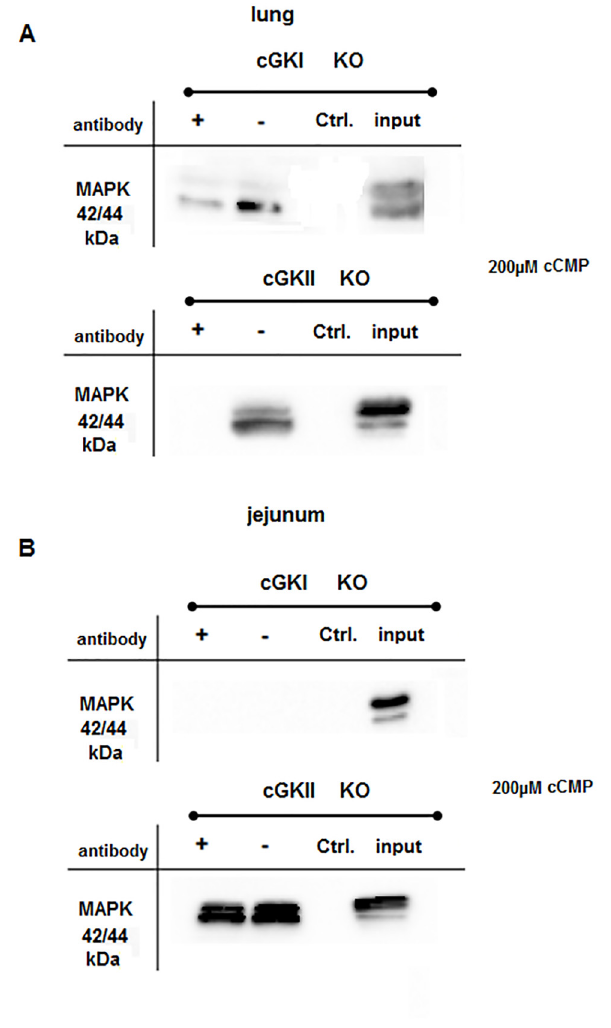
Fig 5. Identification of cCMP-binding proteins (A) Lung tissue lysate (cGKI KO or cGKII KO) was incubated with 4-AH-cCMP agarose beads or EtOH-NH-agarose beads (ctrl). For the competition experiments, cCMP (200 μ M) was added (+) or omitted (-) as described in the Material and Methods. Untreated tissue lysate (1 μ g/ μ L, indicated with input) was used as an additional control. cCMP-binding proteins were analyzed by electrophoresis and immunoblotting with an antibody directed against p44/42 MAPK. (B) Same panel as (A) using jejunum tissue lysate. (S3 Fig) Same experiment depicted in Fig 5 using +/- 2 mM cCMP for competition (WT, cGKI KO and cGKII KO tissue